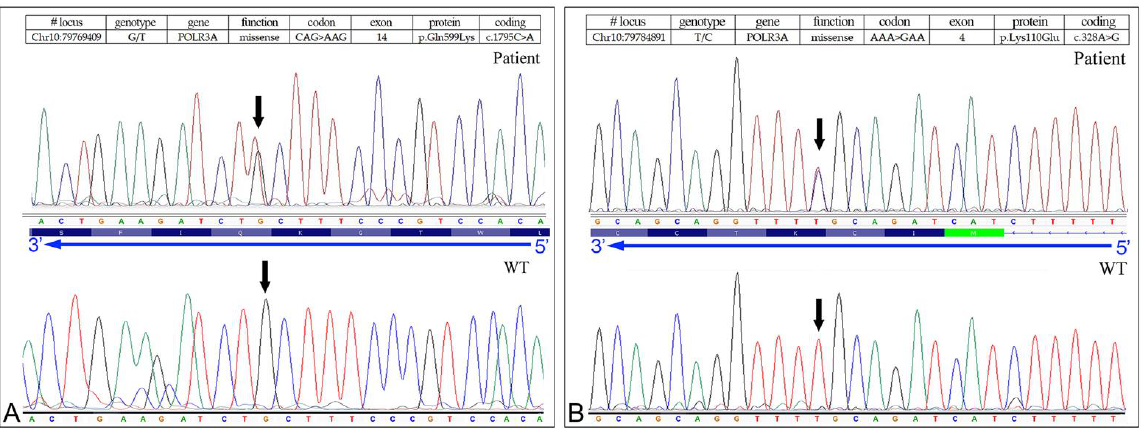
Figure 4. Sanger sequencing electropherograms showing, in the upper part, the compound heterozygous missense variants in the 5078-NP1688 patient. ( A ) c.1795C > A, (p.Gln599Lys) in the POLR3A